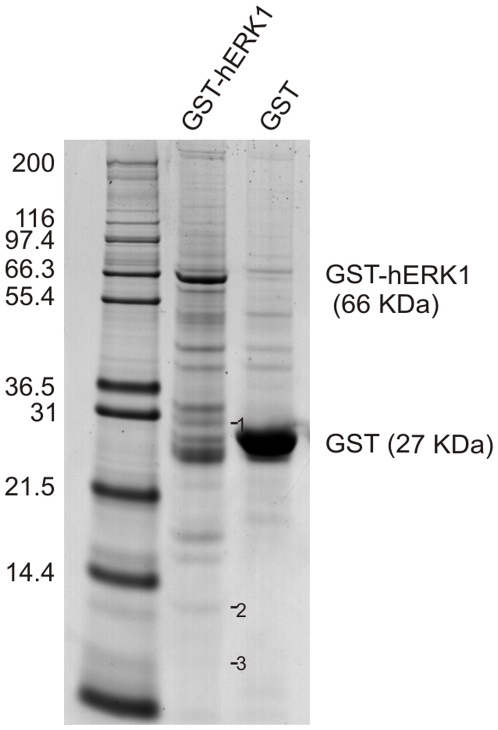
hERK1-GST pulldown assay. GST-hERK1 or GST-null recombinant proteins immobilized on GSH-agarose were incubated overnight with a mitochondrial extract.Beads were extensively washed and eluted proteins were run on SDS-PAGE. Proteins were stained with Coomasie Brilliant Blue G-250. Molecular weight markers displayed on the left. GST-hERK1 and GST-null recombinant proteins highlighted on the right. Numbers on the right side of the bands recovered in GST-hERK lane represent proteins identified by mass spectrometry and shown in Table 1.